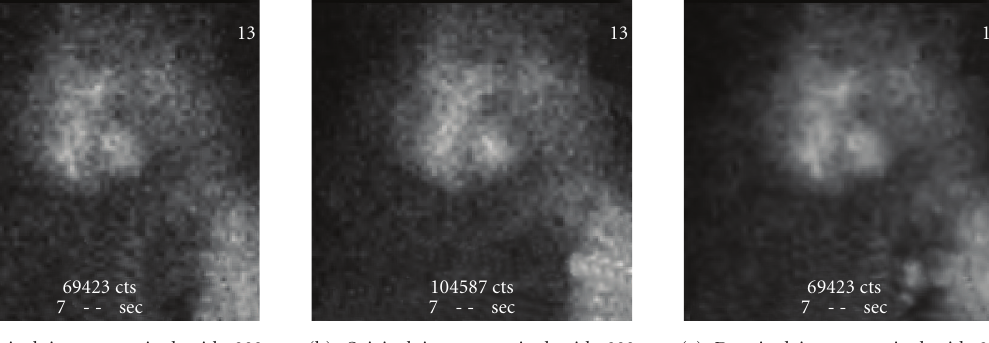
Figure 7: Example of a slide of comparative tests.